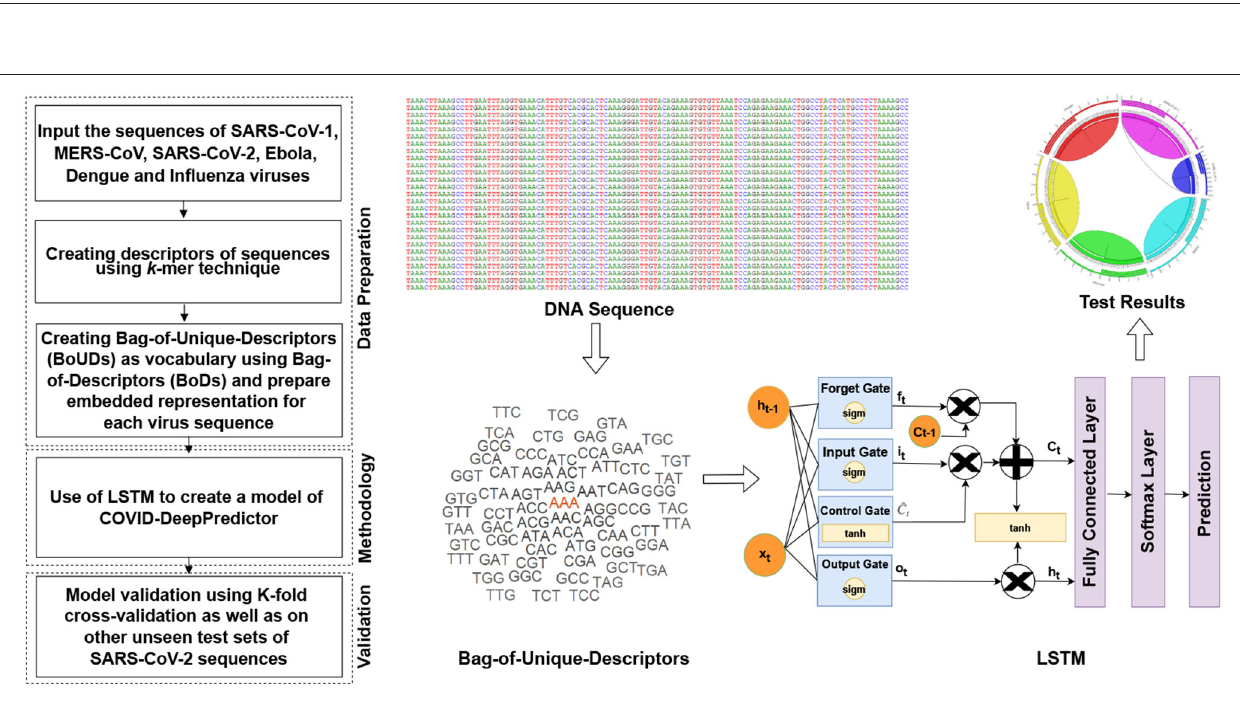
SARS-CoV-2, Ebola, Dengue, and Influenza. For each